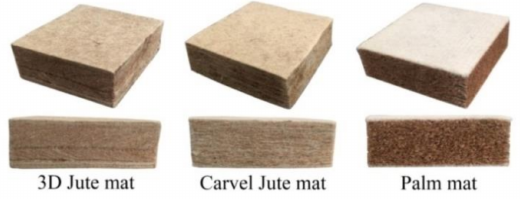
Figure 9. The three types of plant fiber